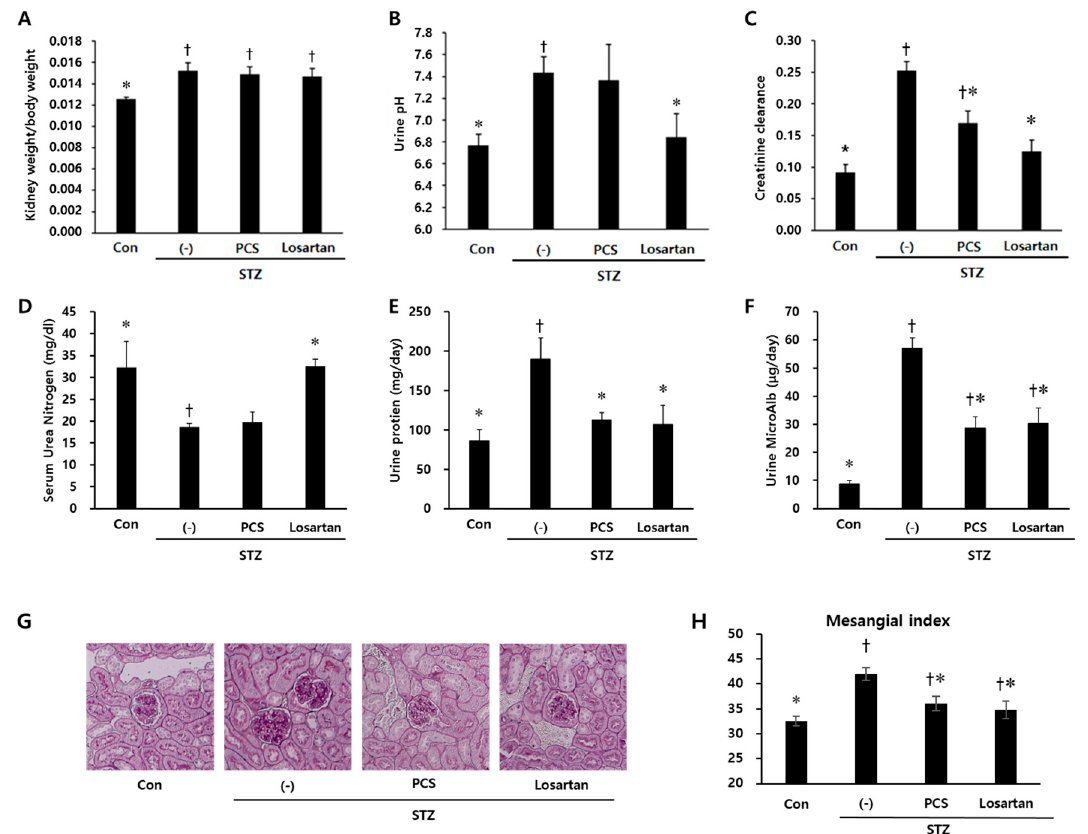
Figure 2. Parameters of renal function in PCS extract-treated, STZ-induced diabetic mice. Mice were treated as described in Figure 1 ( n = 8–11/group). ( A ) The ratio of kidney weight/body weight; ( B ) Urine pH; ( C ) Creatinine clearance; ( D ) Serum urea nitrogen; ( E ) Urinary protein; ( F )